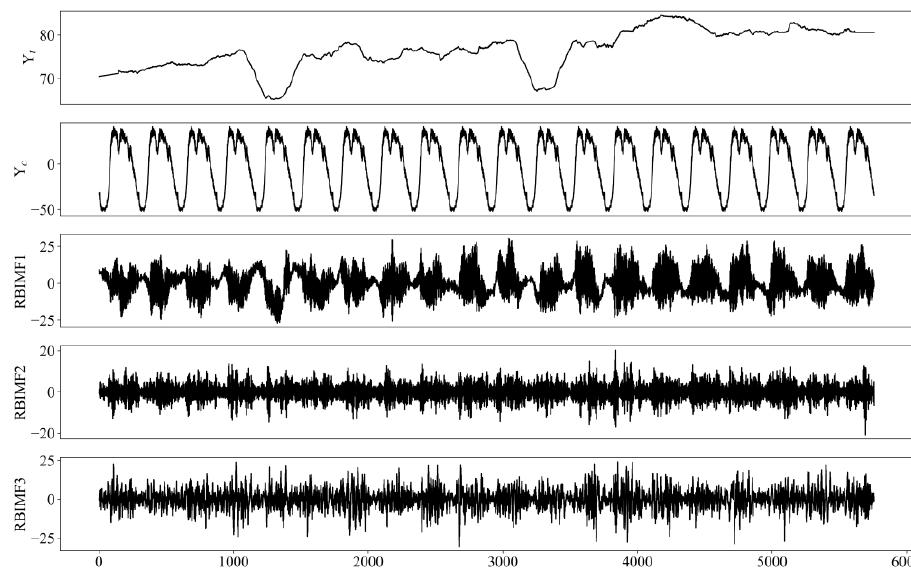
Figure 8. Reconstructed component results.